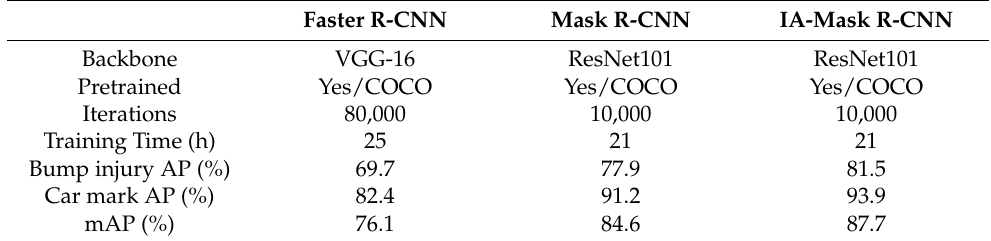
Table 3. Surface defect detection results of automotive engine parts of the three detection